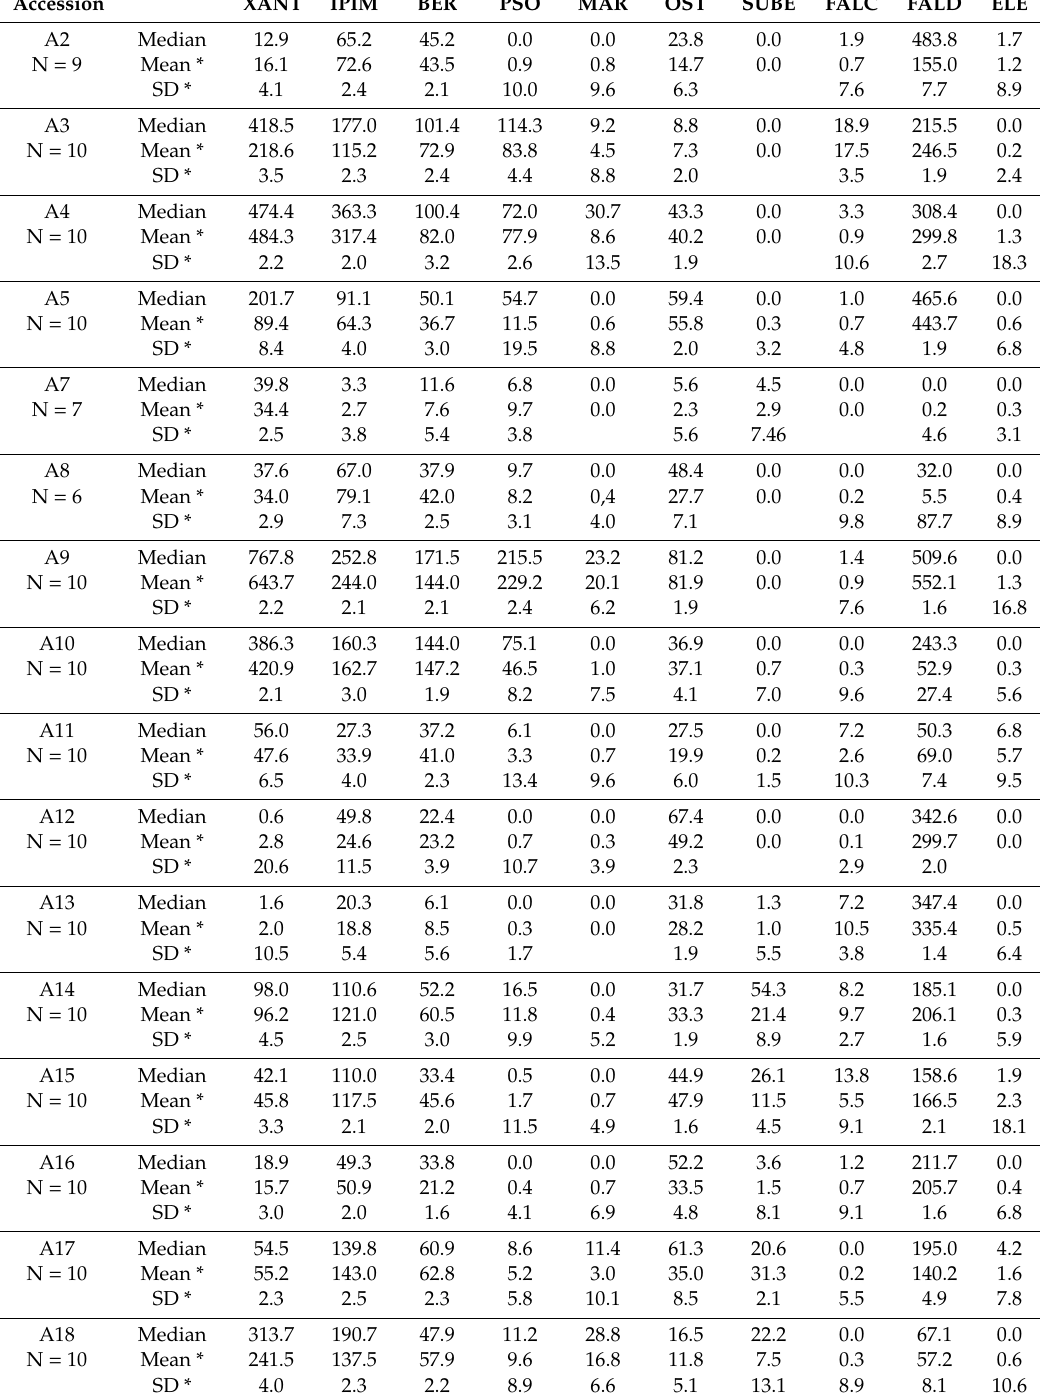
Table 2. Active compounds in 16 Conium maculatum accessions (mg /